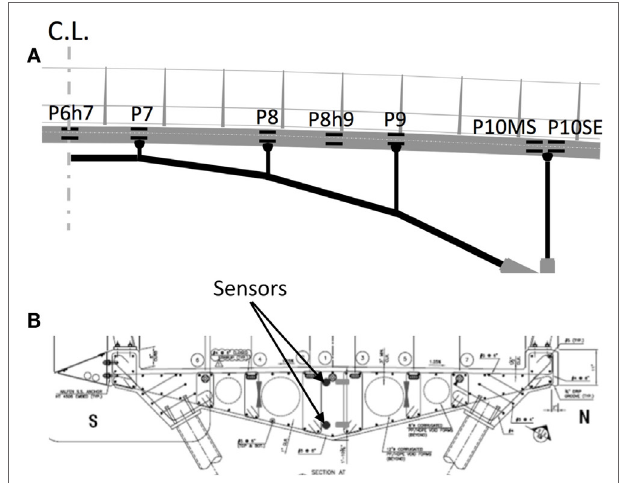
FIGURe 2 | Monitoring system on the main span of streicker Bridge: (A) elevation view and (B) cross-sectional view .